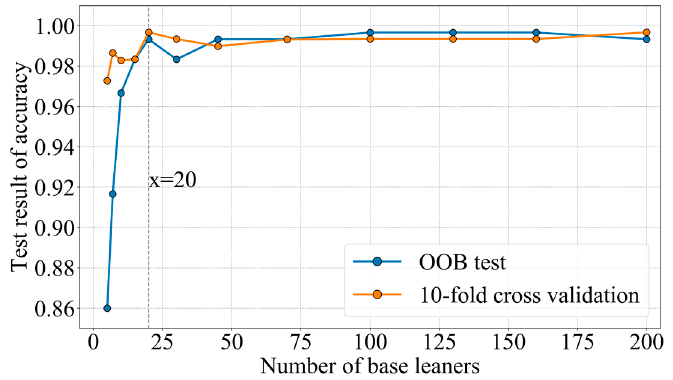
Figure 9. Relationship between the scale and accuracy of the RF models. Table 2. Confusion matrix of recognition results.